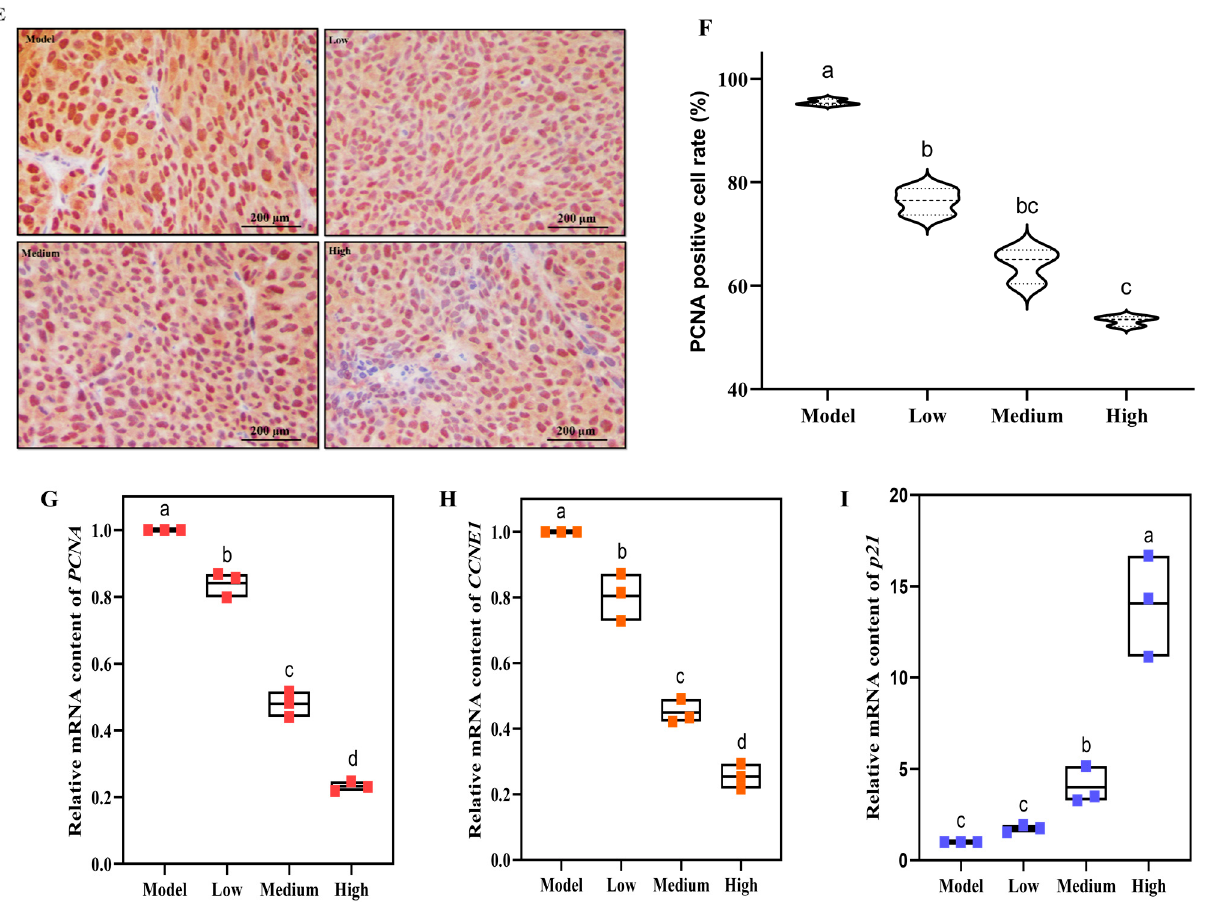
Figure 5. Effect of SCS on regulating cell proliferation pathway in HT-29 xenograft tumor mice model. Total RNA was extracted from xenograft tumor and the gene expression of cell proliferation markers was detected by qPCR. ( A ) Effect of SCS on Tumor Necrosis factor (TNF- α ); ( B ) Effect of SCS on Interleukin 1 β (IL-1 β ); ( C ) Effect of SCS on Interleukin 6 (IL-6); ( D ) Effect of SCS on Interleukin 10 (IL-10); ( E ) Xenograft tumor tissues were collected after sacrifice and sectioned for proliferating cell nuclear antigen (PCNA) staining; ( F ) Representation images of PCNA staining; ( G ) The relative mRNA content of PCNA; ( H ) The relative mRNA content of CCNE1; ( I ) The relative mRNA content of P21. All results are expressed as mean ± SD ( n = 10). Different superscript letters for each column indicated significant differences ( p < 0.05) as compared to every other group.